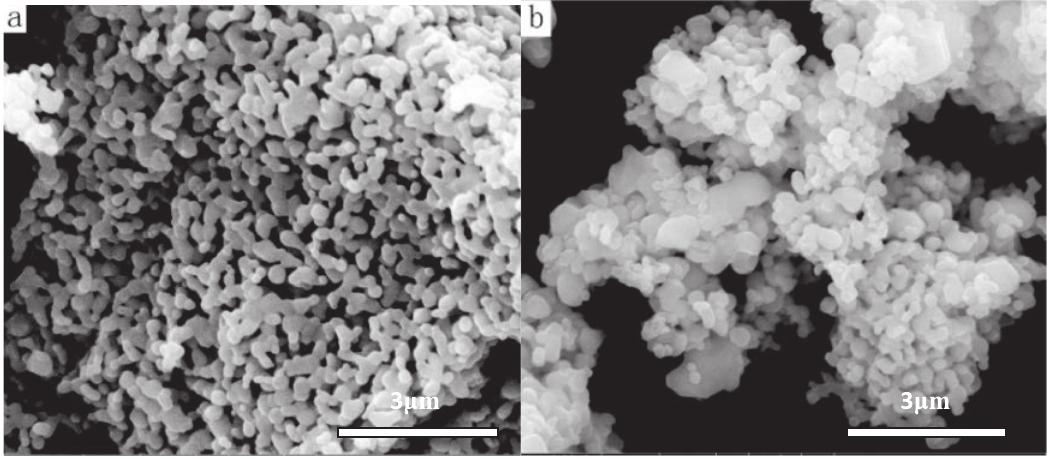
Fig. 7: SEM images of the hematite powder obtained at 850°C, (a) conventional method and (b) calcinations by